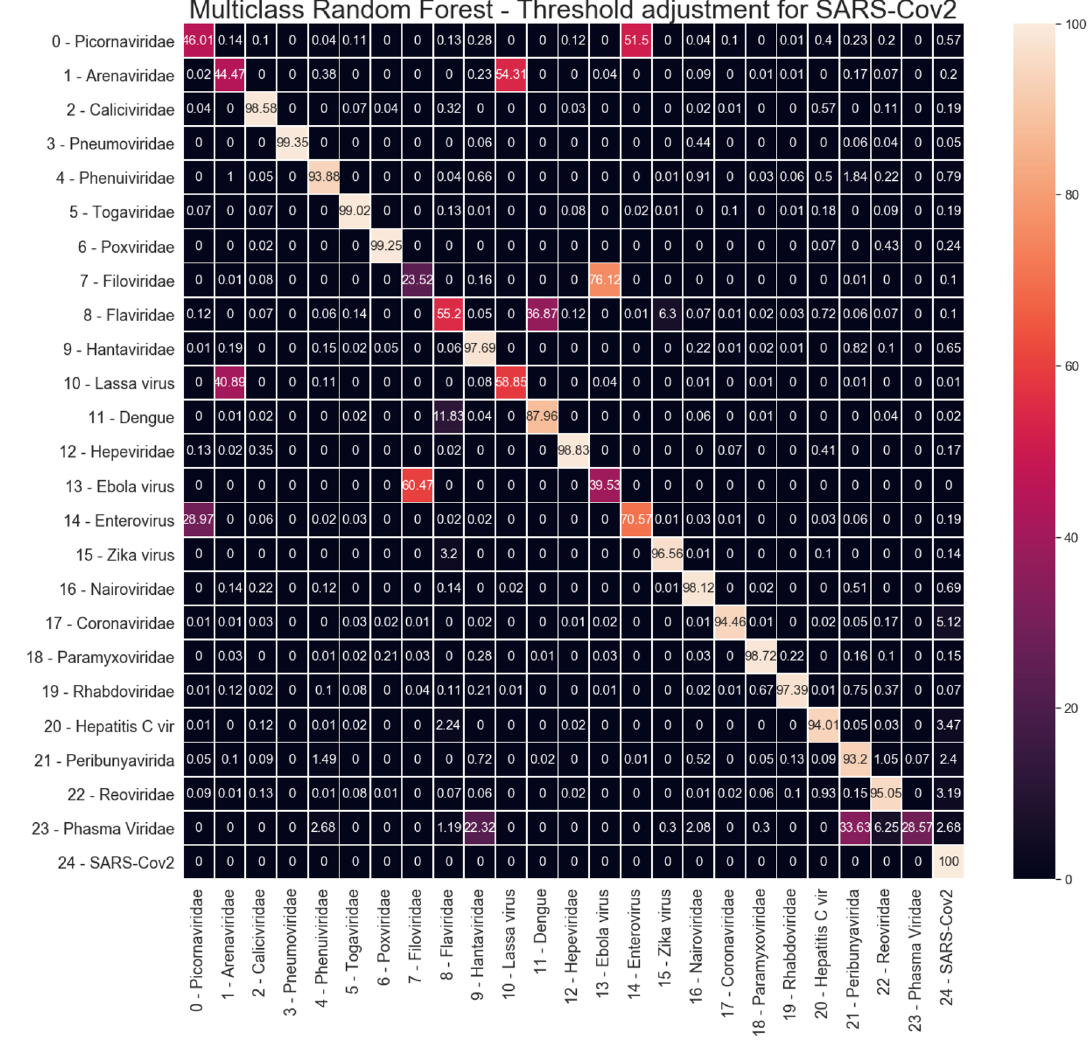
Figure 9. Random Forest average Confusion Matrix with threshold adjustment for 100% sensitivity on SARS- CoV-2 (index